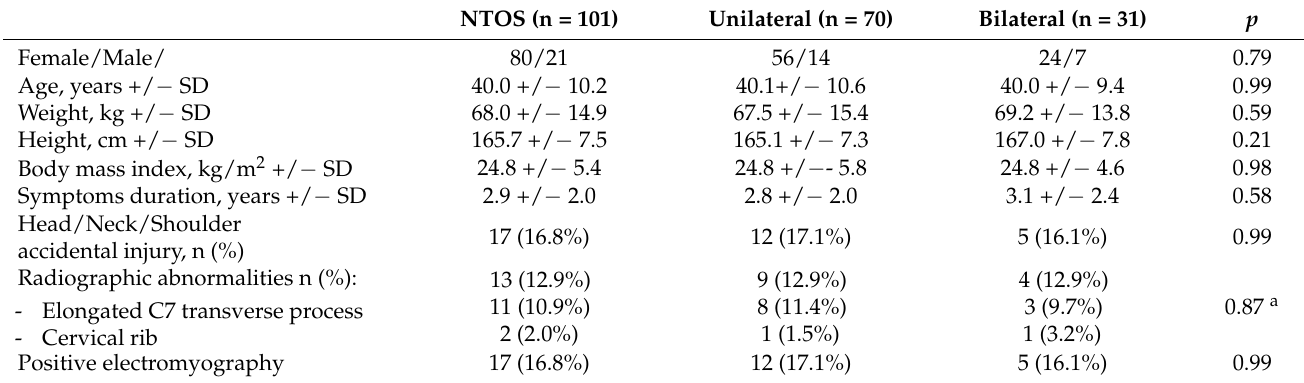
Table 2. Population with NTOS and comparison between patients with unilateral and bilateral forms.